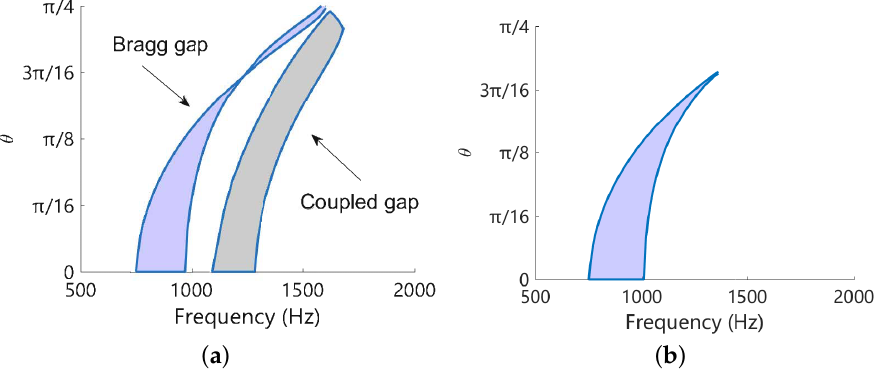
Figure 11. Variation of the angular width of band gaps with respect to the frequency: ( a ) L-network with L = 0.1 H; ( b ) without circuitry network.